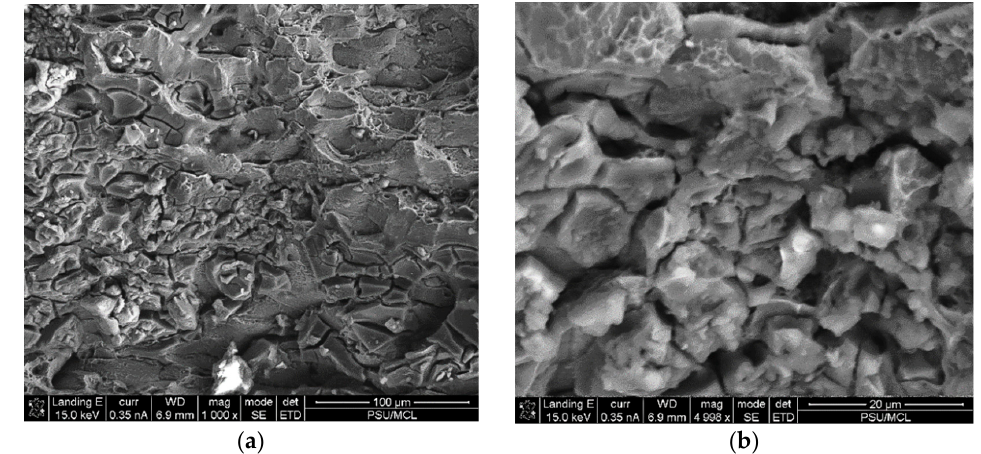
Figure 16. Secondary electron images of wrought Al 6061-T6 fracture surfaces. The fractography predominately shows ( a ) cleavage as well as intergranular fracture with ( b ) the grain boundaries attacked in the 25% yield stress condition.